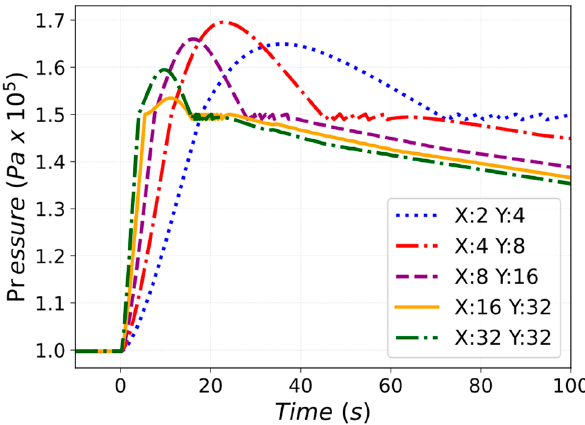
Figure 20. Pressure in the PHTS for different numbers of relief panels.